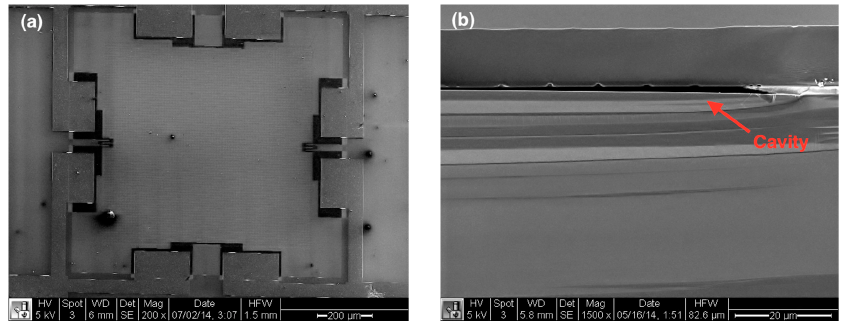
Figure 6. ( a ) Top view of a piezoresistive pressure sensing element by SEM; ( b ) SEM cross-section view of a sensing element.